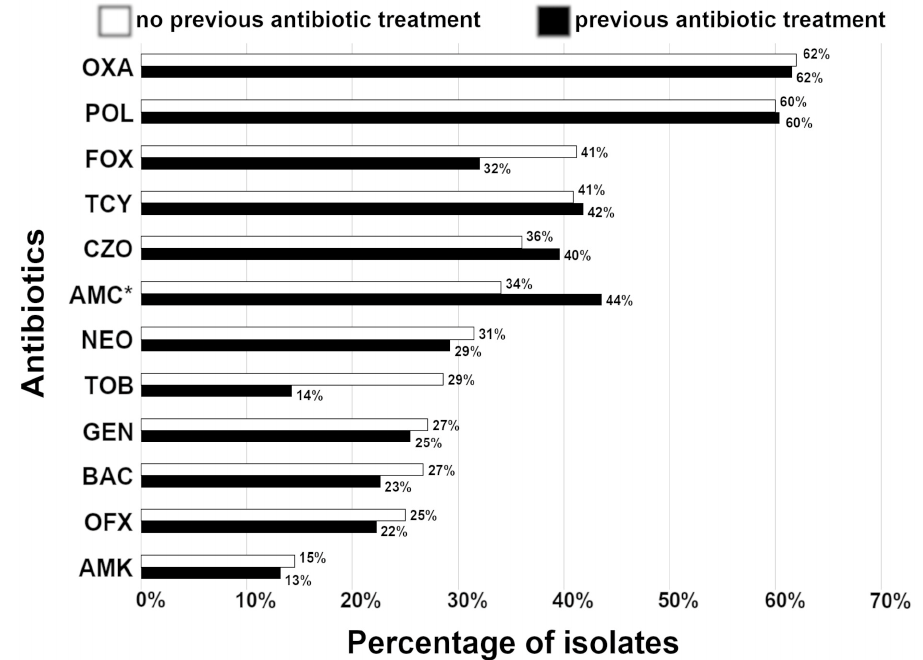
Figure 3. Acquired resistance in isolates from corneal stromal ulcers regarding the patient’s previ- ous antibiotic treatments. Percentage (%) of resistant bacterial species against antibiotics excluding intrinsic resistance of isolates. The number of isolates range from 16 to 60 for the patients without previous antibiotic treatments and from 13 to 106 for the patients with previous antibiotic treat- ments. * = although amoxicillin/clavulanic acid is not used topically, data for this antibiotic are presented here since it is often used postoperatively as a systemic antibiotic. Abbreviations: AMC, amoxicillin/clavulanic acid; AMK, amikacin; BAC, bacitracin; CZO, cefazolin; FOX, cefoxitin; GEN, gentamicin; NEO, neomycin; OFX, ofloxacin; OXA, oxacillin; POL, polymyxin B; TCY, tetracycline; TOB,